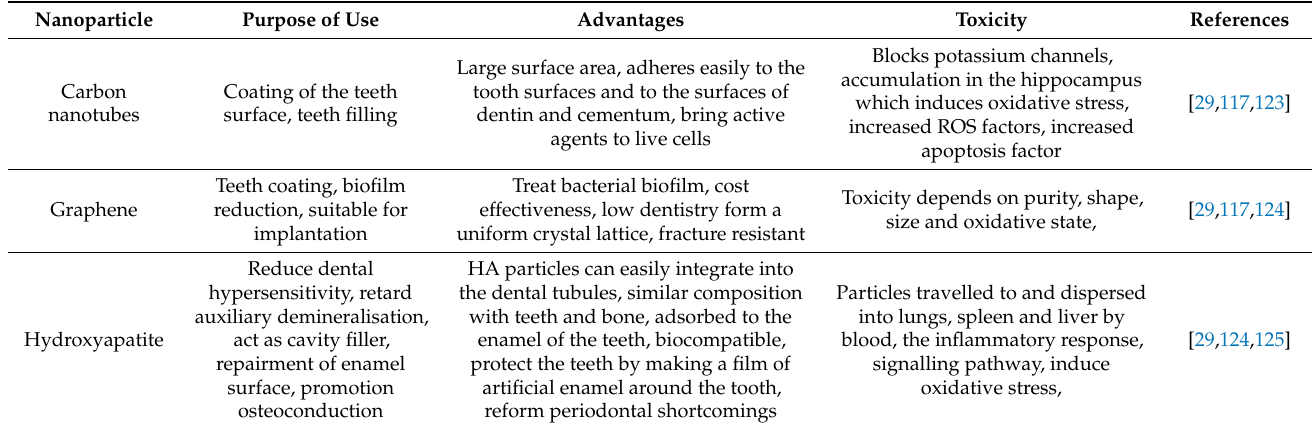
Table 2. Nanoparticles used in nanocomposites for dental